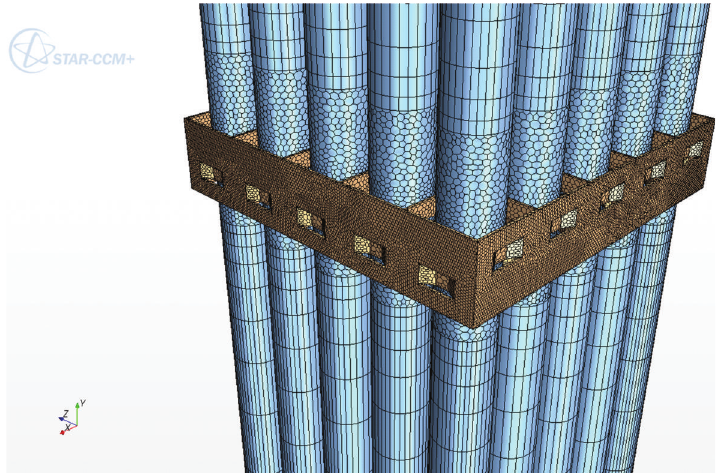
Figure 3: CFD grid of simple spacer.